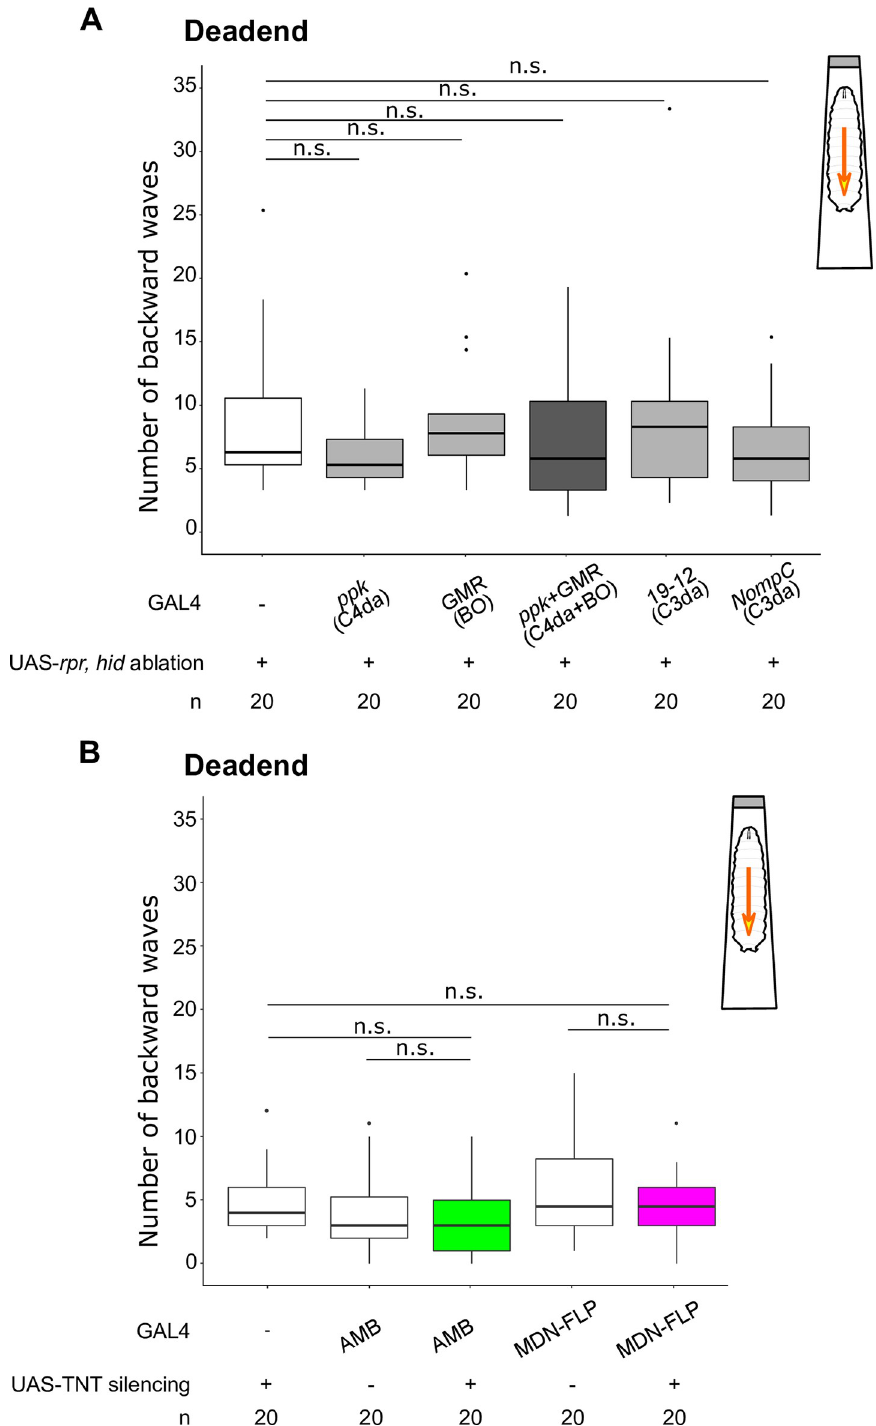
Fig 12. AMBs and MDNs are dispensable for dead ends-evoked backward waves in larvae. The number of backward waves evoked by the dead ends with ablation of sensory neurons (A), or silencing AMBs or MDNs (B). The number of backward waves was counted for 1 min after an animal encounter the dead end in the chamber. Genotypes are shown in S1 Table. In the boxplot, the width of the box represents the interquartile range. The whiskers extend to the data point which is less than 1.5 times the length of the box away from the box, and the dot represent outlier. We assessed statistical significance by the Wilcoxon rank sum test with the Holm method.